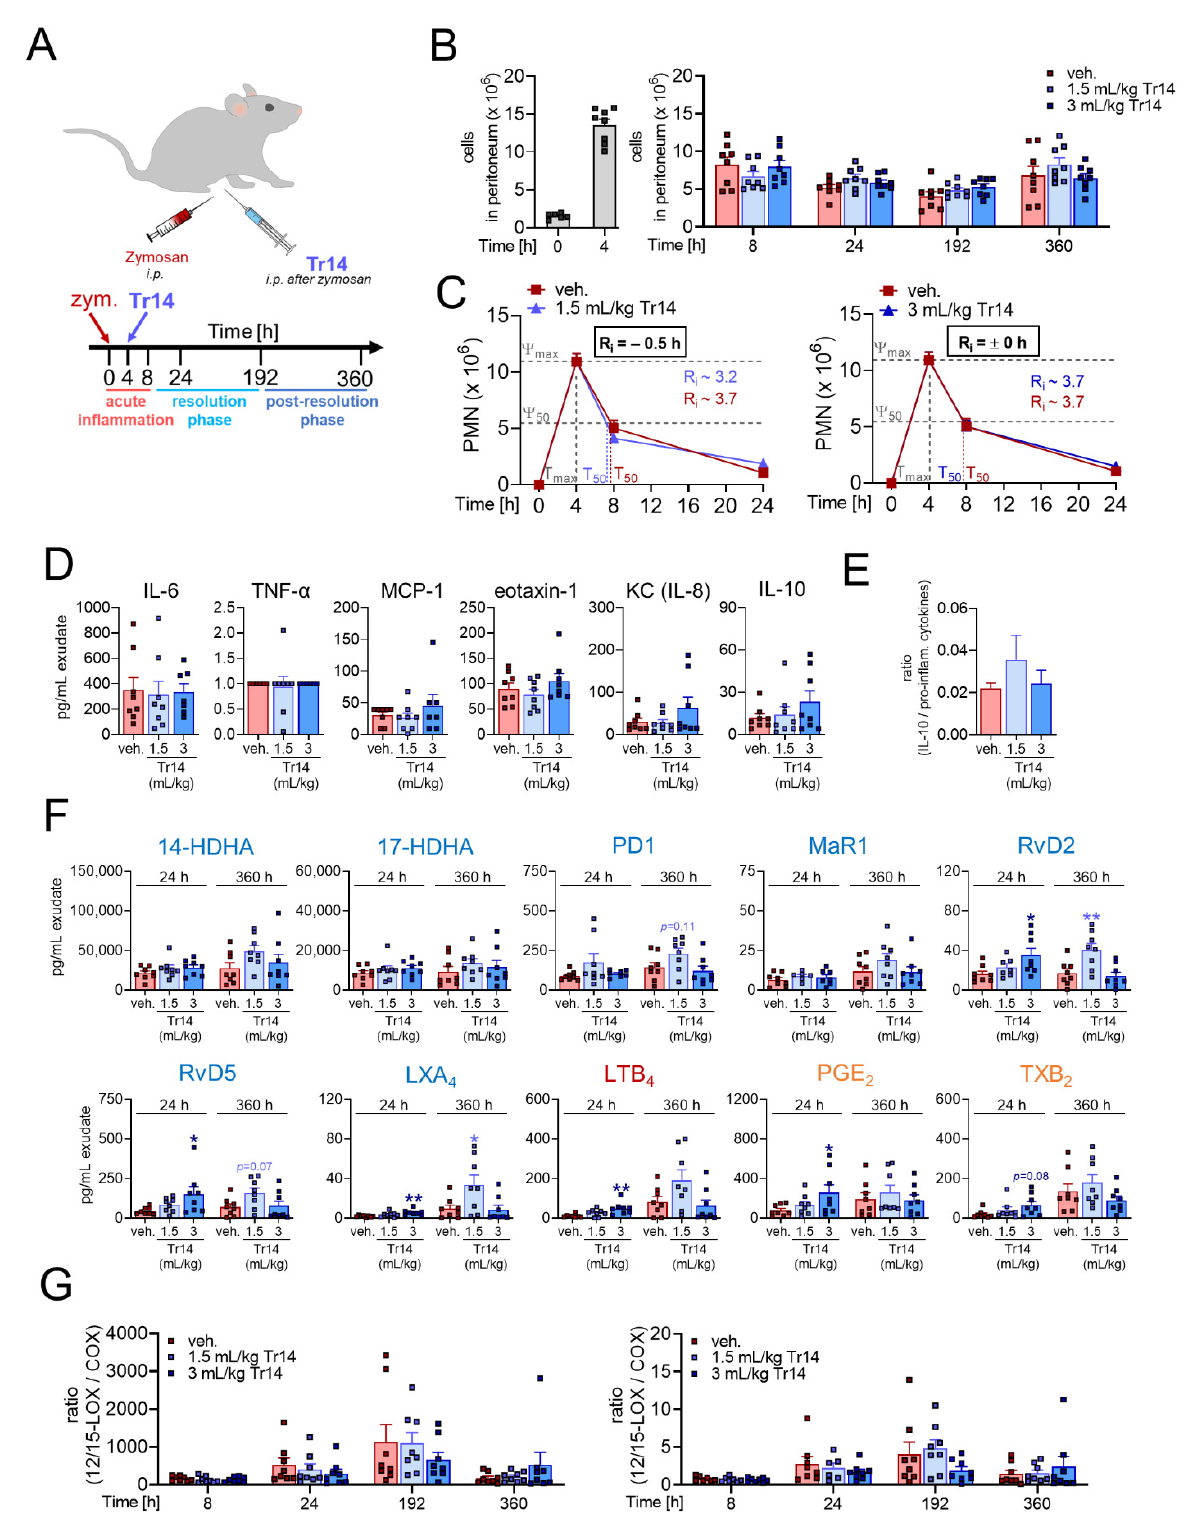
Figure 2. Effects of Tr14, administered i.p. 4 and 8 h post-induction of murine peritonitis, on resolution of inflammation and on lipid mediator pathways. ( A–G ) Self-resolving inflammation was initiated by injecting zymosan (0.1 mg/mouse, i.p. ) into mice. Tr14 (1.5 mL/kg or 3 mL/kg) or vehicle (veh., 0.9% NaCl) were administered i.p. 4 and 8 h post-zymosan injection. Peritoneal exudates were collected after 4, 8, 24, 192 and 360 h ( n = 6–8; outliers were removed) after zymosan injection, and from naïve untreated mice representing time point 0 h ( n = 6). ( A ) Scheme of administration of Tr14 and induction of peritonitis. ( B ) Quantification of cell numbers in the peritoneal lavages, shown as single values and mean + SEM for the indicated time points. Left panel shows cell numbers in the peritoneum of naïve (untreated) mice at t = 0 and